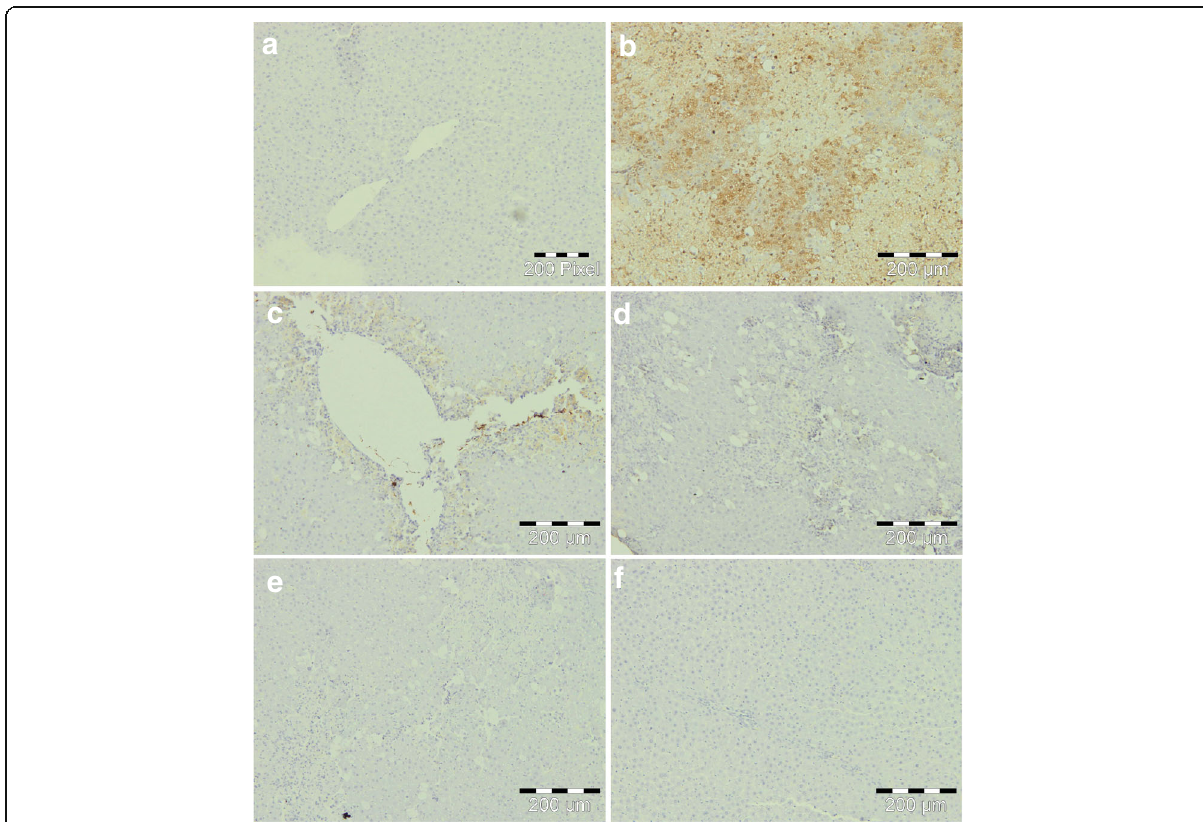
Fig. 10 Immunohistochemical appearance of TNF- α . a Control group, normal. b CCl 4 (1 ml/kg b.wt.), high expression of TNF- α . c C. nudiflora (150 mg/kg b.wt. + CCl 4 ), low expression of TNF- α . d C. nudiflora (300 mg/kg b.wt. + CCl 4 ), low expression of TNF- α . e C. nudiflora (450 mg/kg b.wt. + CCl 4 ), low expression of TNF- α . f C. nudiflora alone (450 mg/kg b.wt.),